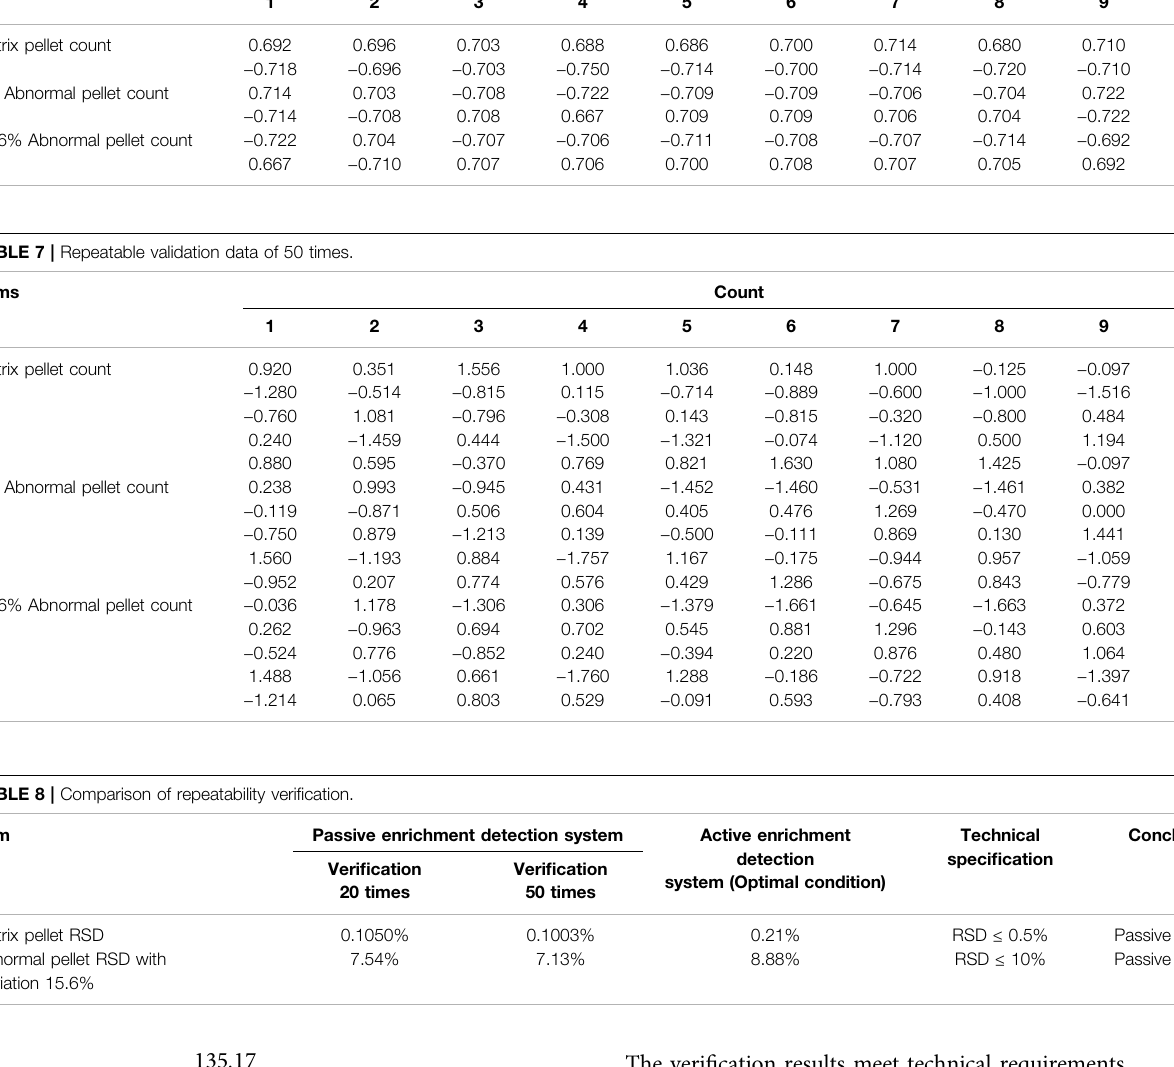
TABLE 6 | 20 Times of repeatable validation data. Items